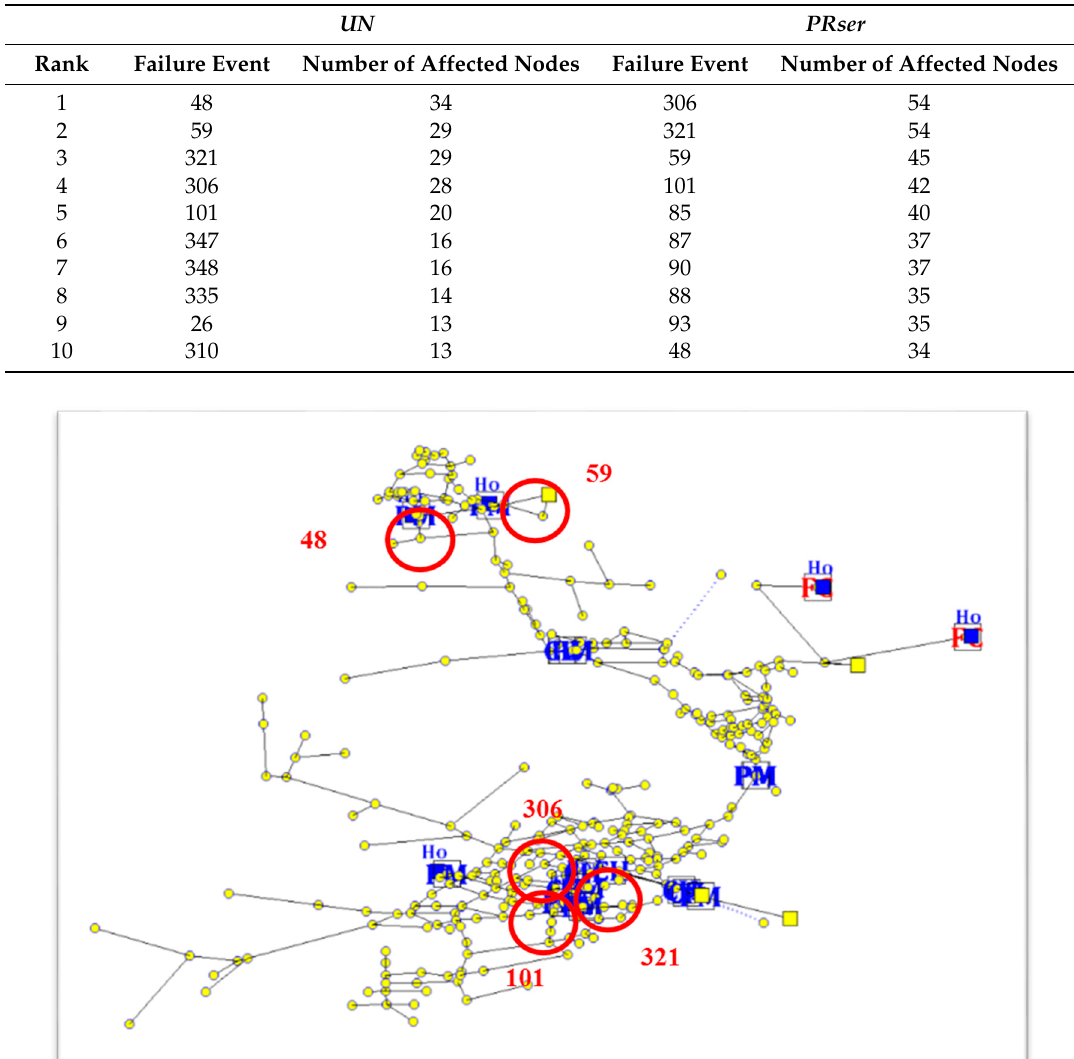
Table 1. List of top-10 failure events corresponding to the number of affected nodes.